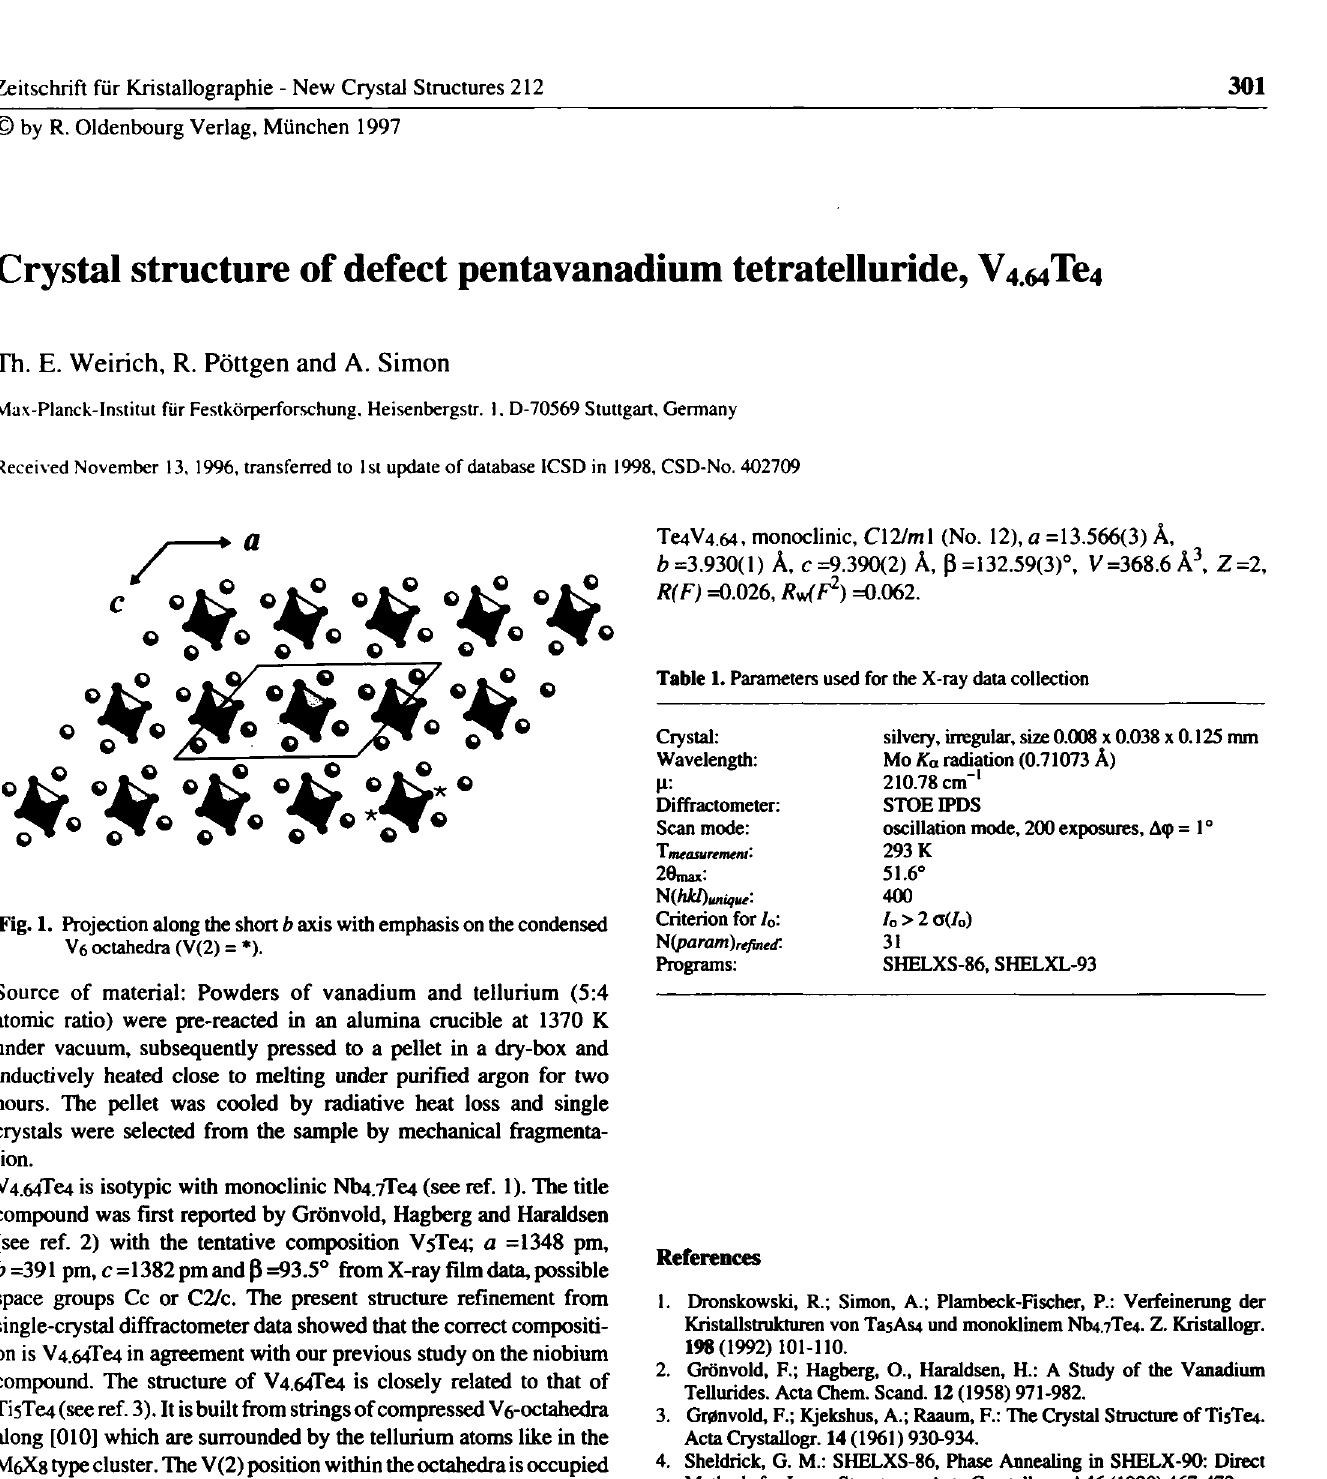
Table 2. Final atomic coordinates and displacement parameters (in Â 2 )